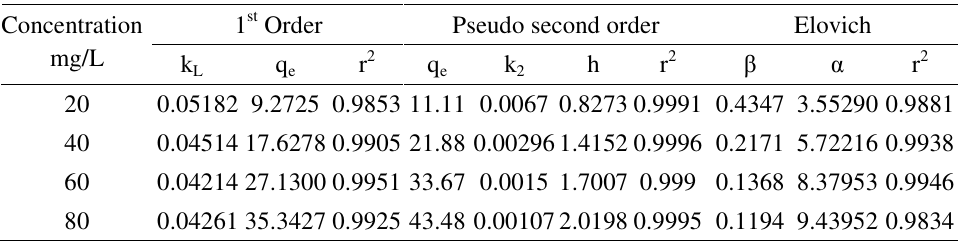
Table 1. Kinetic model values for adsorption of methylene blue onto activated babul seed carbon 1 st